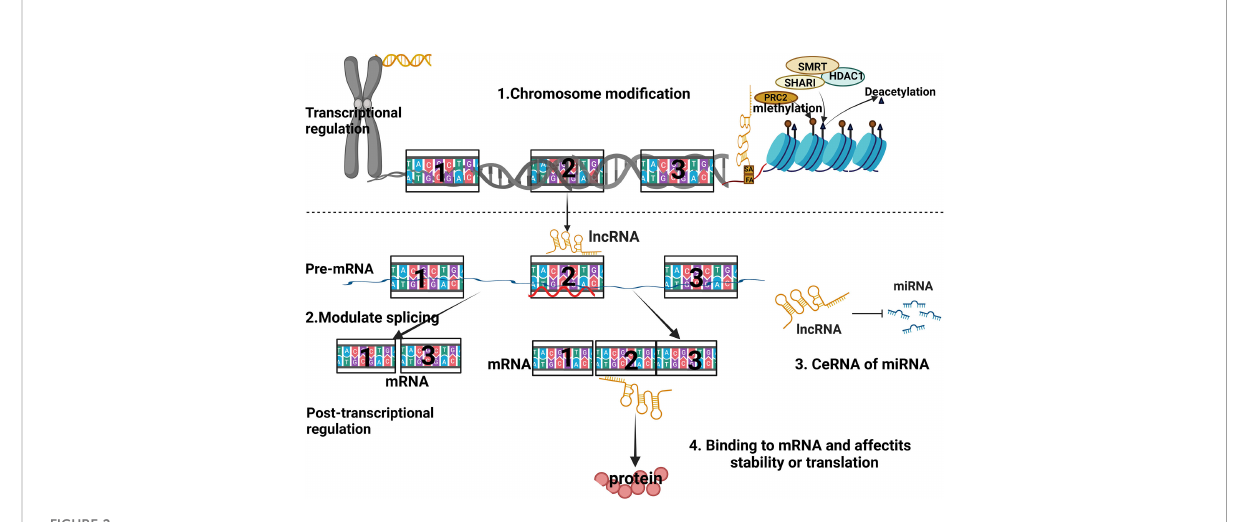
FIGURE 2 Schematic diagram of the regulatory mechanism of